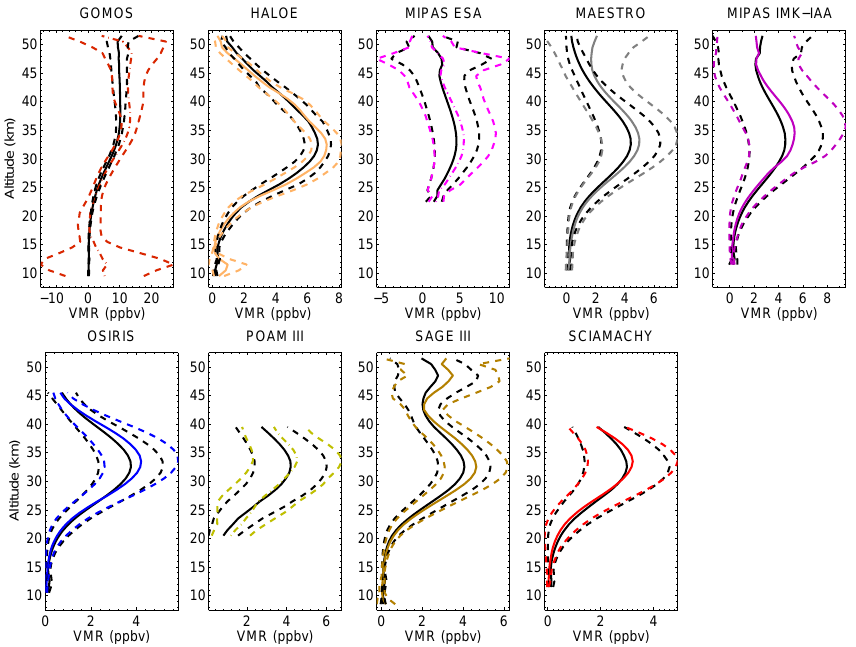
Figure 6. Mean NO 2 profiles (in ppbv) for coincident diurnally scaled ACE-FTS (black) and INST (coloured) measurements and corre- sponding measurement standard deviations (dashed lines). Coincidence criteria for all comparisons are within 4h and 350km.